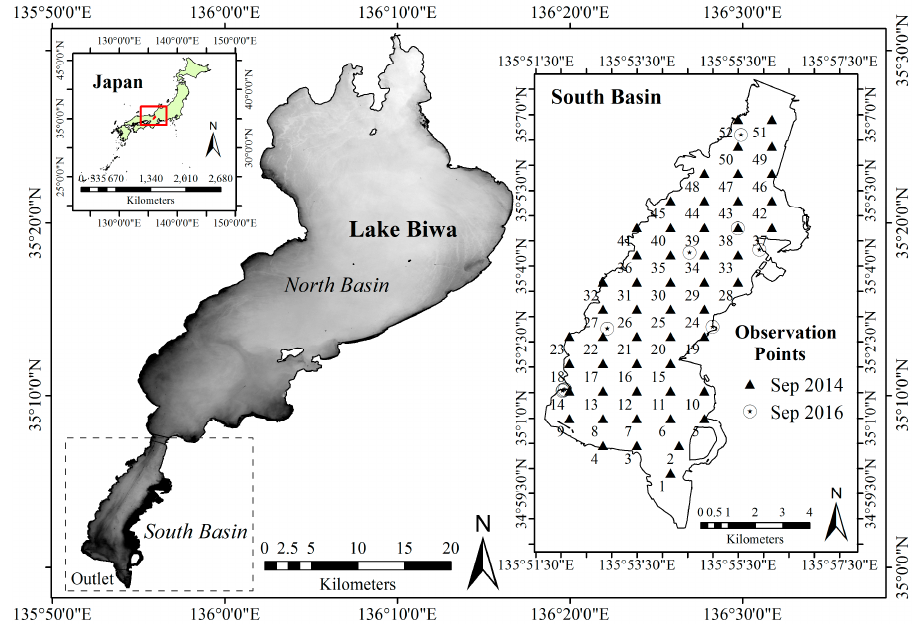
Figure 1. Geographical location of Lake Biwa and its southern basin with water quality and submerged aquatic vegetation (SAV) observation points. aquatic vegetation (SAV) observation